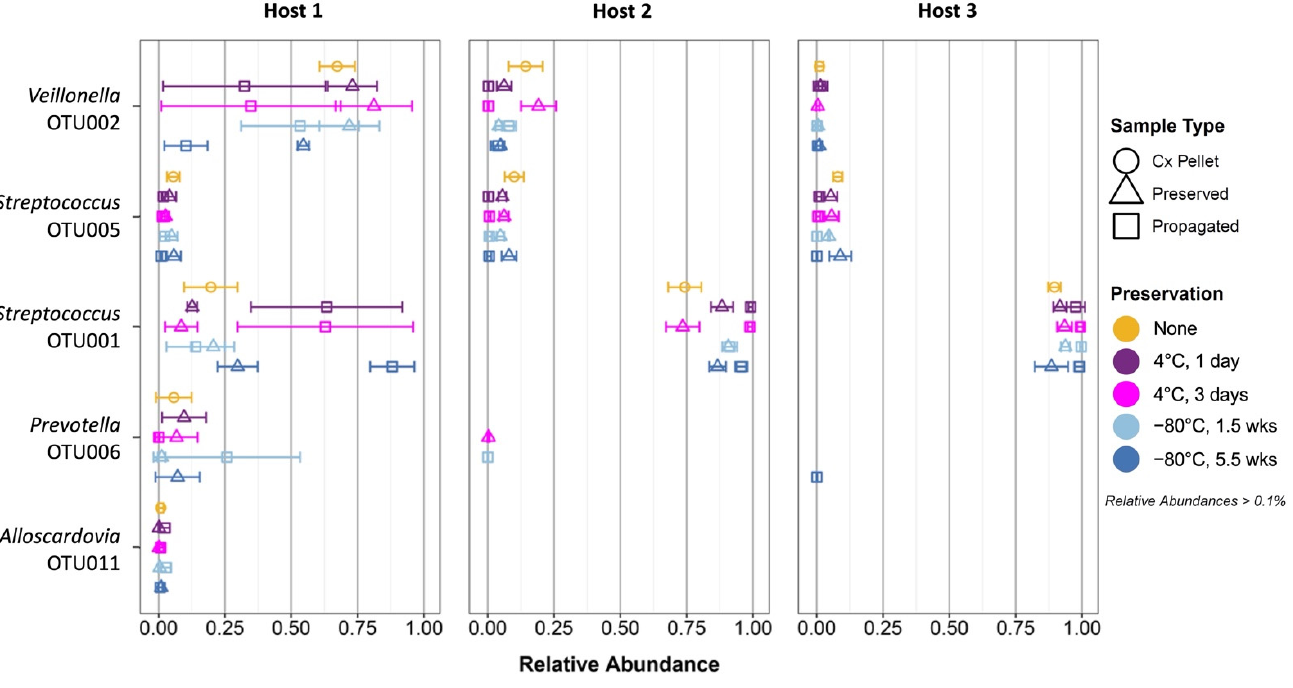
Figure 4. Relative abundances of the most prominent OTUs for each host. “Cx Pellet”: initial culture. Averages +/ − standard deviations are shown by horizontal bars.